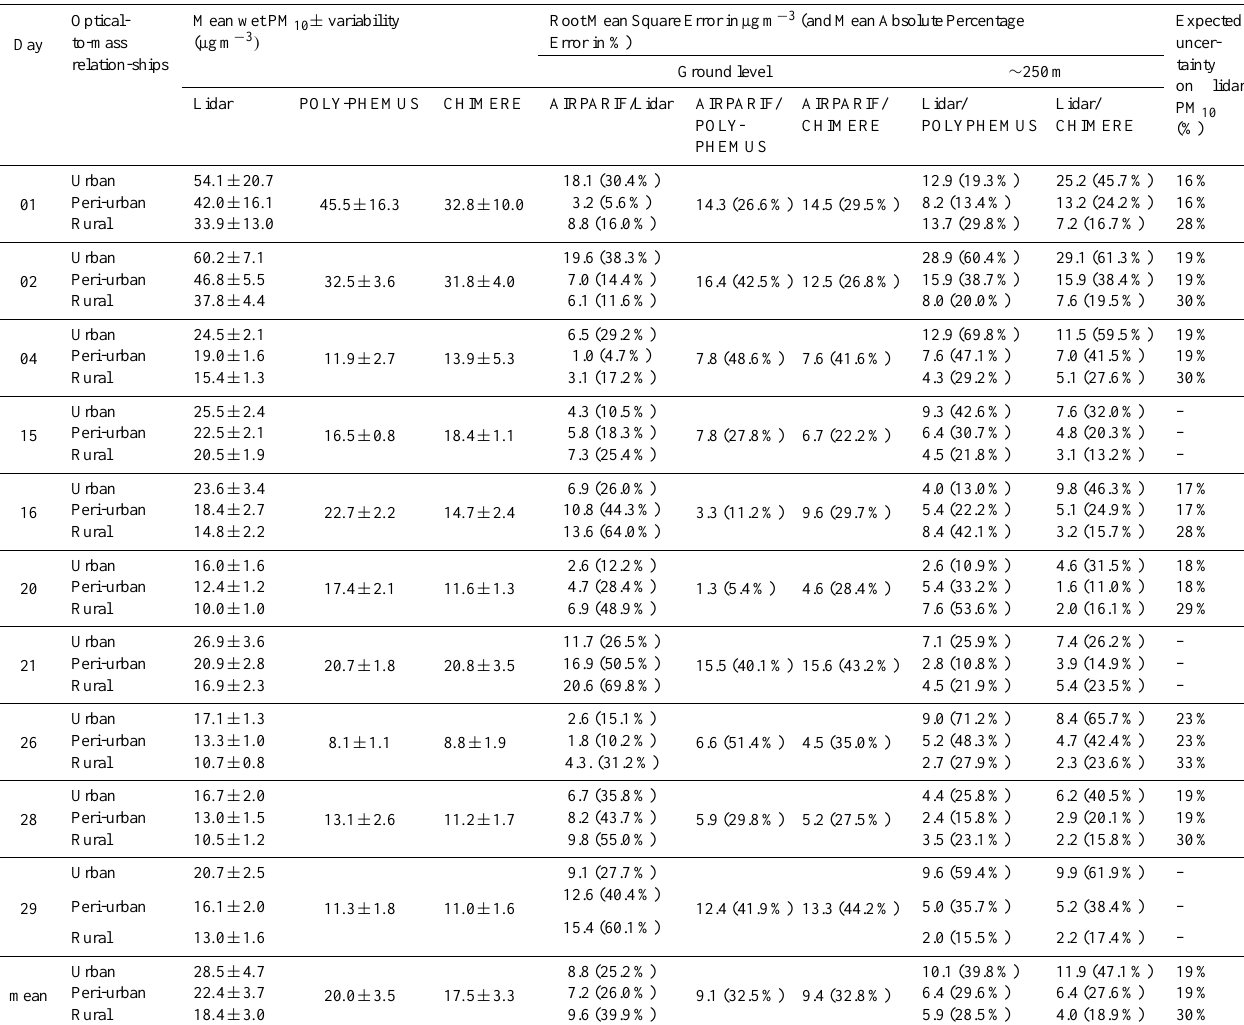
Table 6. Root Mean-Square Errors (RMSE) and Mean Absolute Percentage Error (MAPE) on PM 10 calculated for each MD between GBML/POLYPHEMUS, GBML/CHIMERE, GBML/AIRPARIF, POLYPHEMUS/AIRPARIF and CHIMERE/AIRPARIF at ground level and ∼ 250m height. The comparisons with GBML measurements have been made with rural, peri-urban and urban relationships. The expected uncertainties on GBML-derived PM 10 have also been computed for rural, peri-urban and urban relationships taking into account AOD observed during each MD. Note that for 15 July a mixing of dust and peri-urban relationships has been used in lidar